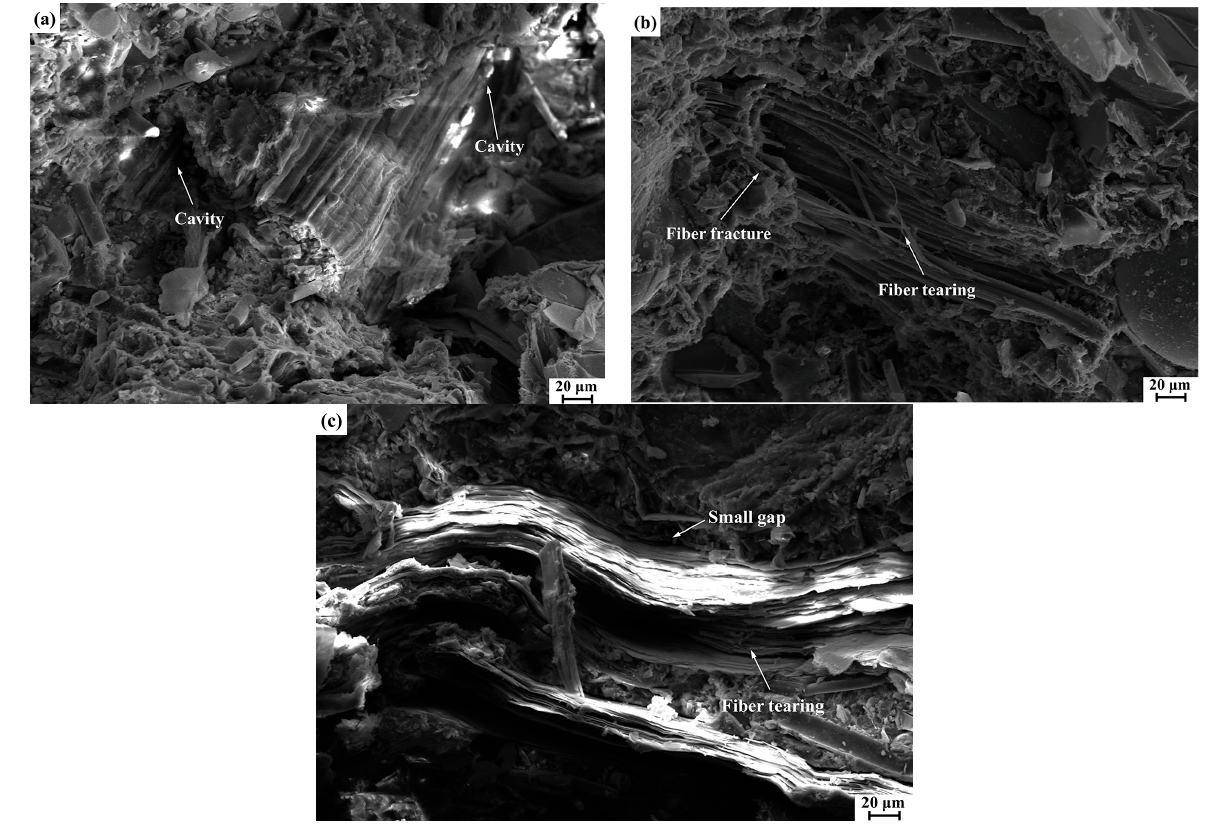
Figure 10. SEM images of the shear fracture surfaces of the composites at 9 wt.% fiber loading: ( a ) CSFC-9, ( b ) CDFC-9, and ( c ) SFC-9.